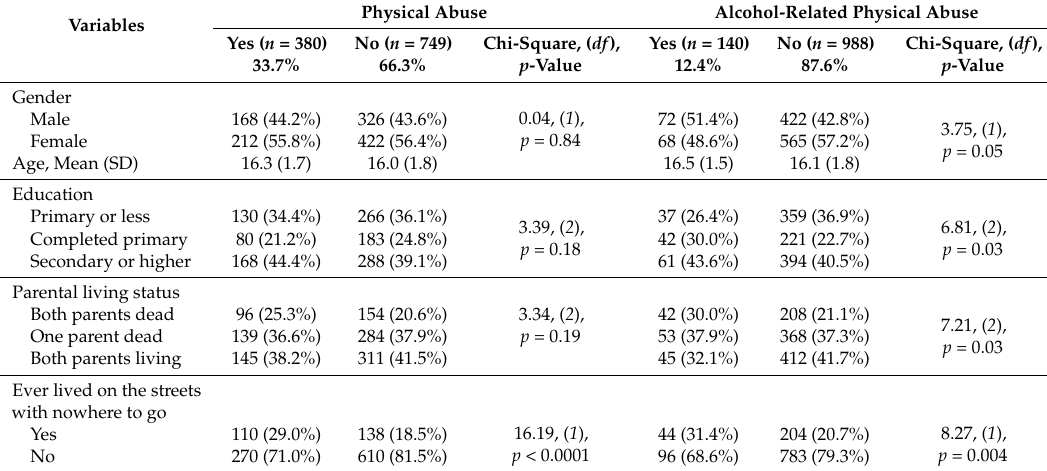
Table 1. Demographic characteristics of children who reported any parental physical abuse or any alcohol-related physical abuse among youth living in the slums of Kampala, ( n =